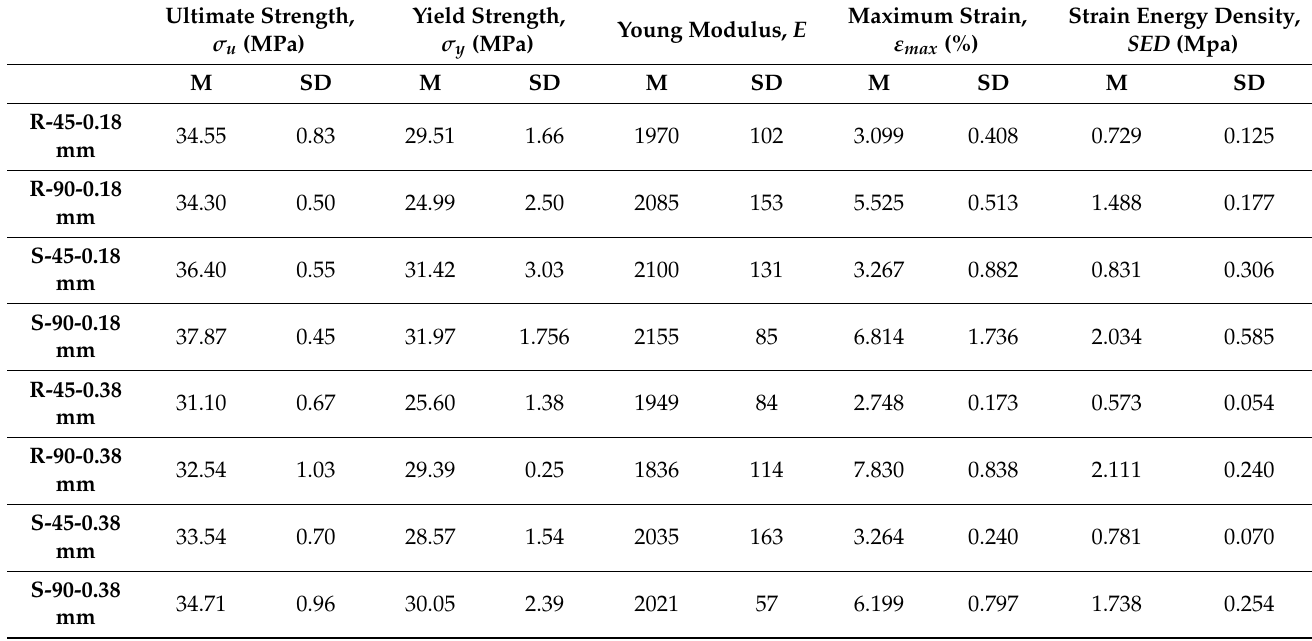
Table 3. Measured mechanical properties of the 3D printed specimens studied in this work. M: mean; SD: standard